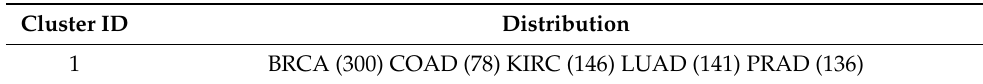
Table 6. The distribution of the hierarchical cluster assignments using median linkage (default settings in R are used) and the gap statistic to select the number of clusters. The gap statistic suggests exactly 1 cluster.